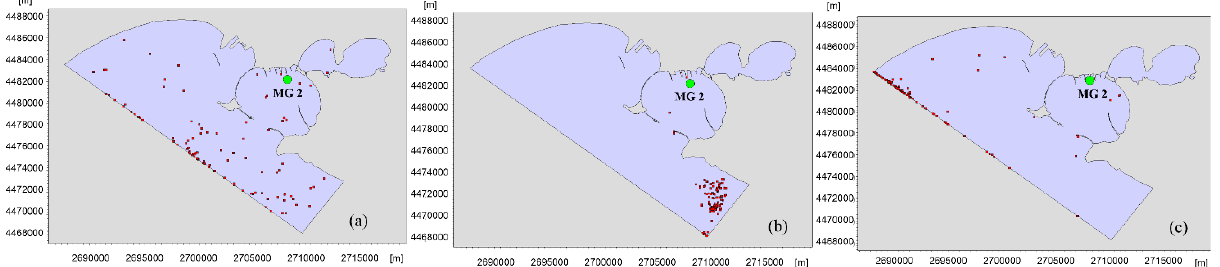
Figure 13. Percentage PT2 (MG2) — the cloud of particles: ( a ) 30 days after release; ( b ) 60 days after release; ( c ) 90 days after release at bottom layer.